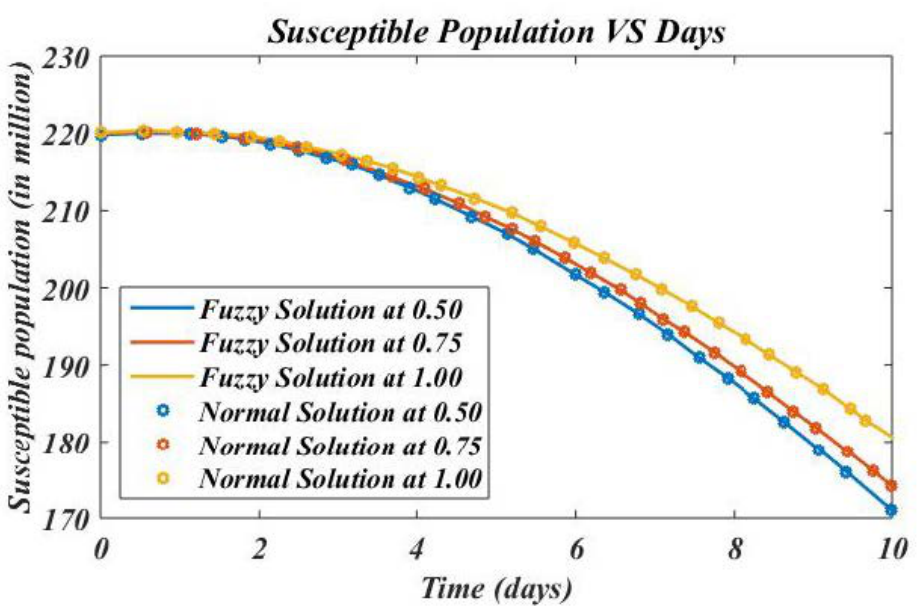
Figure 1. Illustration of approximate fuzzy and normal susceptible compartment solutions for three terms at given uncertainty levels ϑ ∈ [ 1,2 ] versus fractional order.